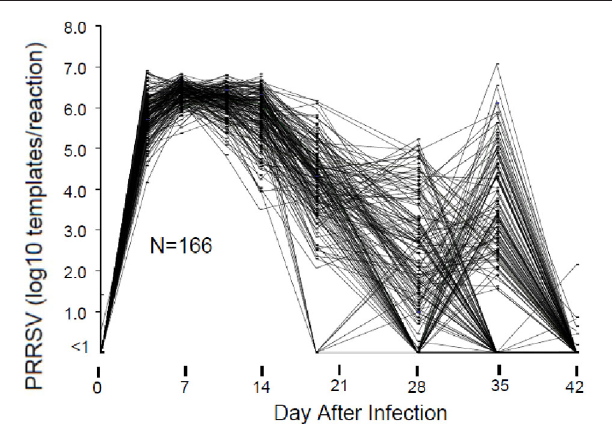
FIGURE 2 | Weight gain during PRRSV infection. Panel (A) shows the weight gain for individual infected pigs for 42 days. Panel (B) shows the weight distribution at 42 days after infection for the same pigs in panel (A) . Black squares represent non-infected reference pigs.